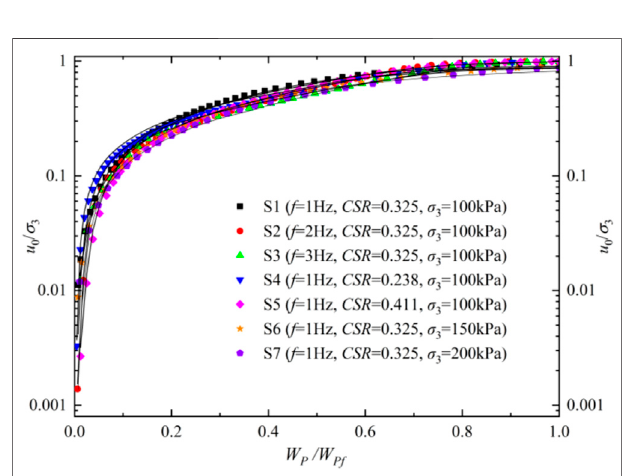
FIGURE 12 | Relation between pore-water pressure ratio and cumulative dissipated